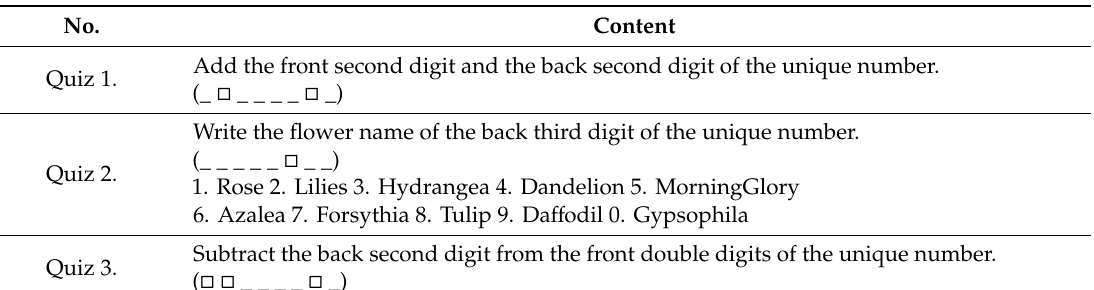
Table 1. Popup quiz content.